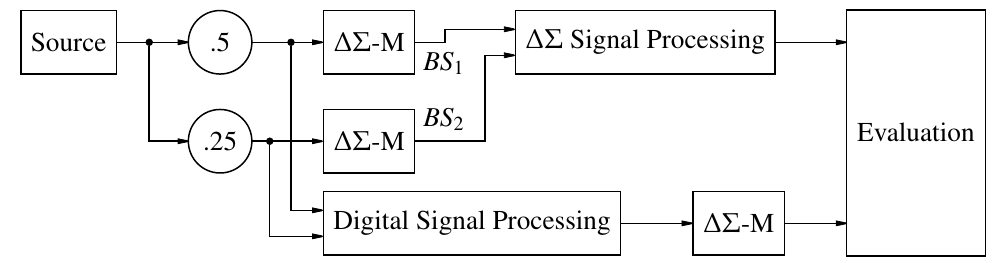
Figure 17. Test bench for evaluating linear ∆Σ SP.